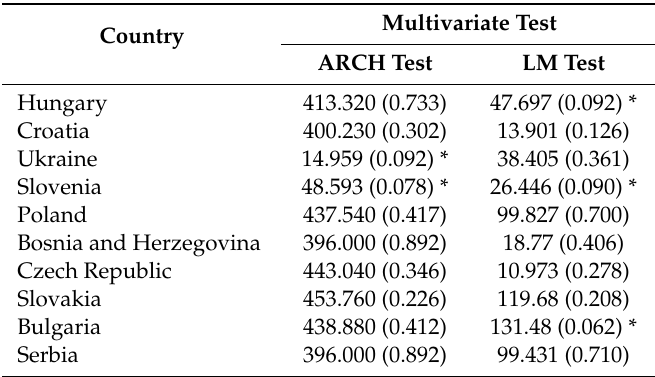
Table A2. Multivariate autocorrelation and heteroskedasticity